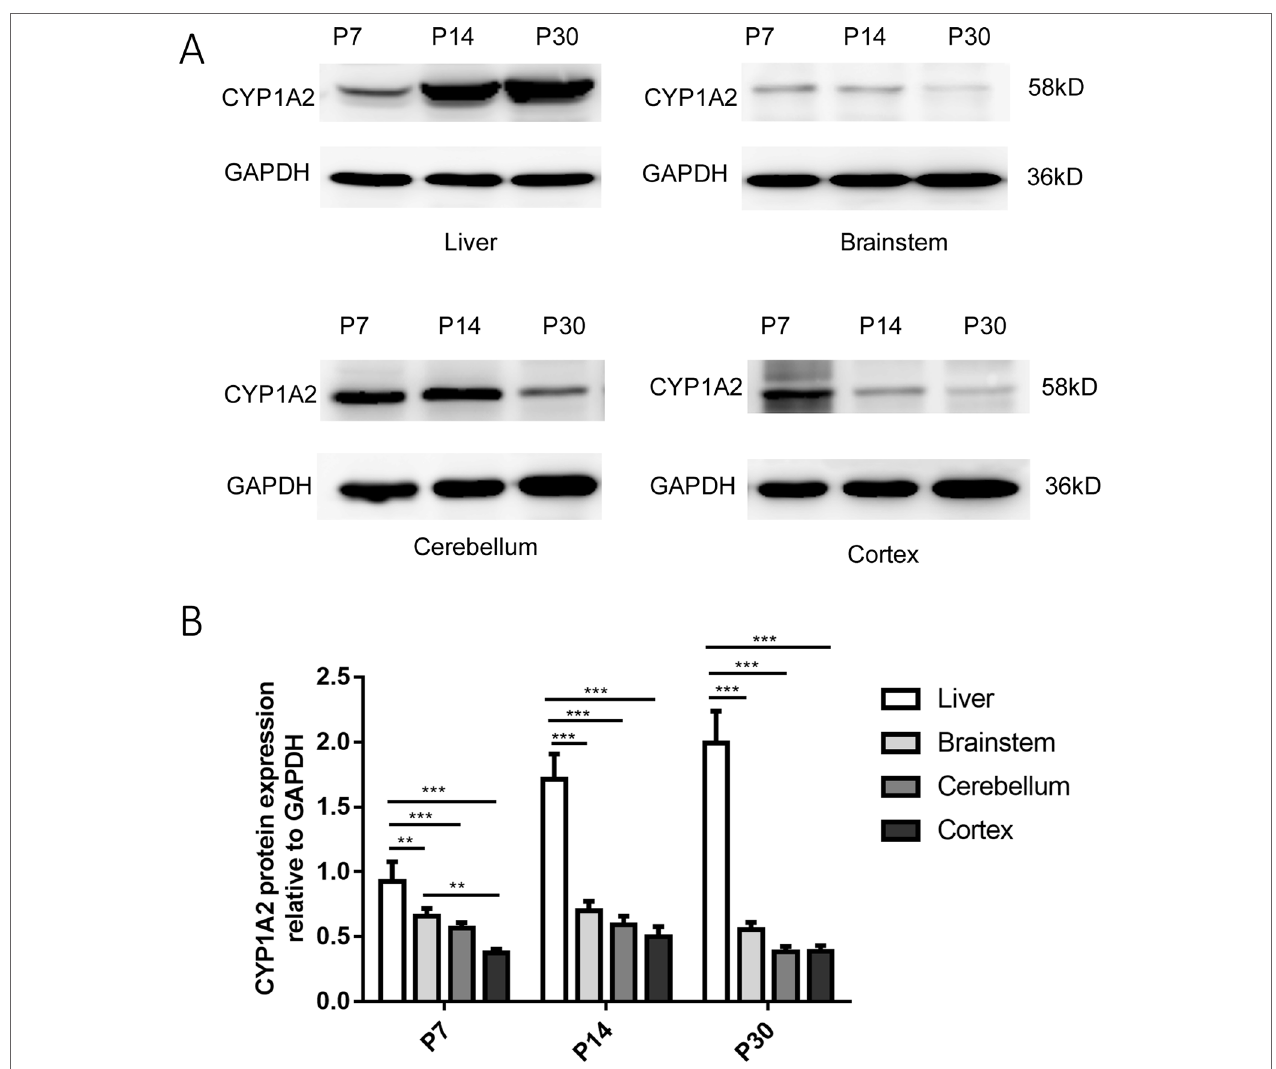
FIGURE 2 | Expression of CYP1A2 protein in the liver and brain. (A) Representative western blot and relative protein expression in the liver and different regions of the brain. The bands at 58 and 36 kDa correspond to CYP1A2 and GAPDH, respectively. (B) GAPDH protein levels are shown as a control. Expression values of protein levels were normalized to those of GAPDH. Each data point represents the mean ± SD of six samples **p < 0.01, ***p < 0.001. P, postnatal